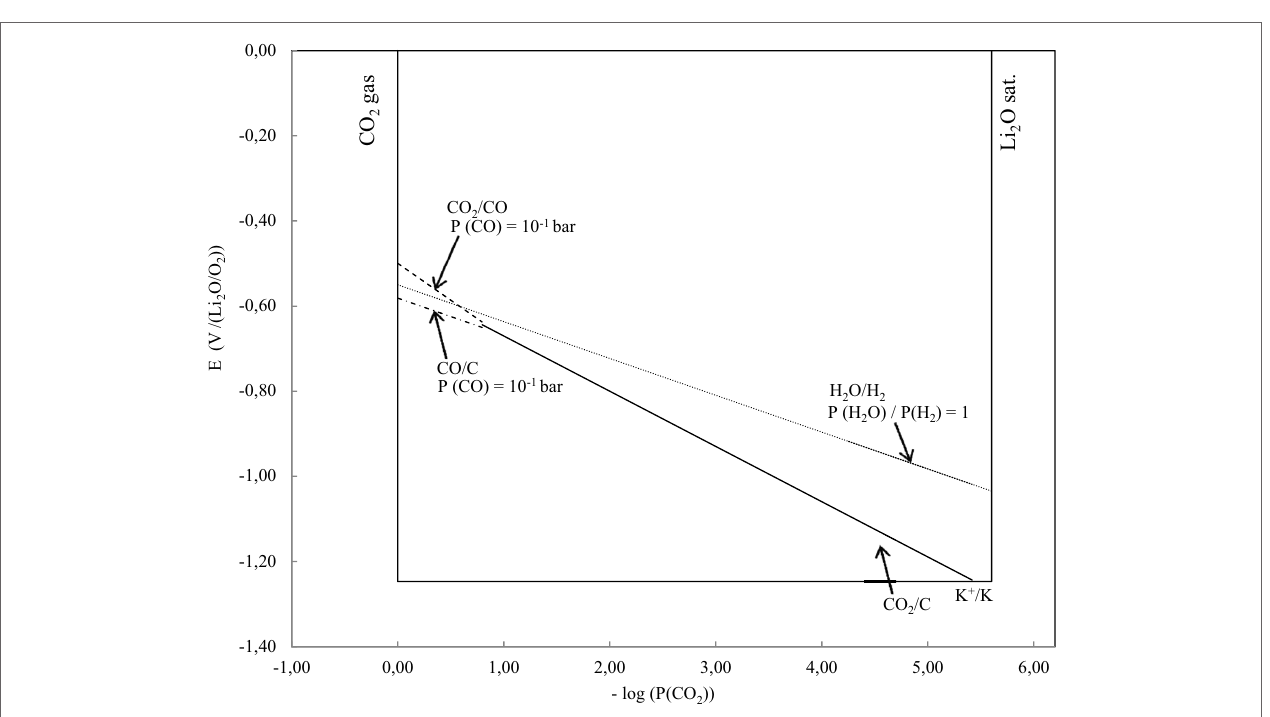
FiGURe 3 | STeP carbon capture in which three molten carbonate electrolysis in series are driven by a concentrator photovoltaic . The maximum power point photovoltage of one Spectrolab CPV is sufficient to drive three in series carbon dioxide splitting 950°C molten Li 2 CO 3 electrolysis cells (Licht et al.,